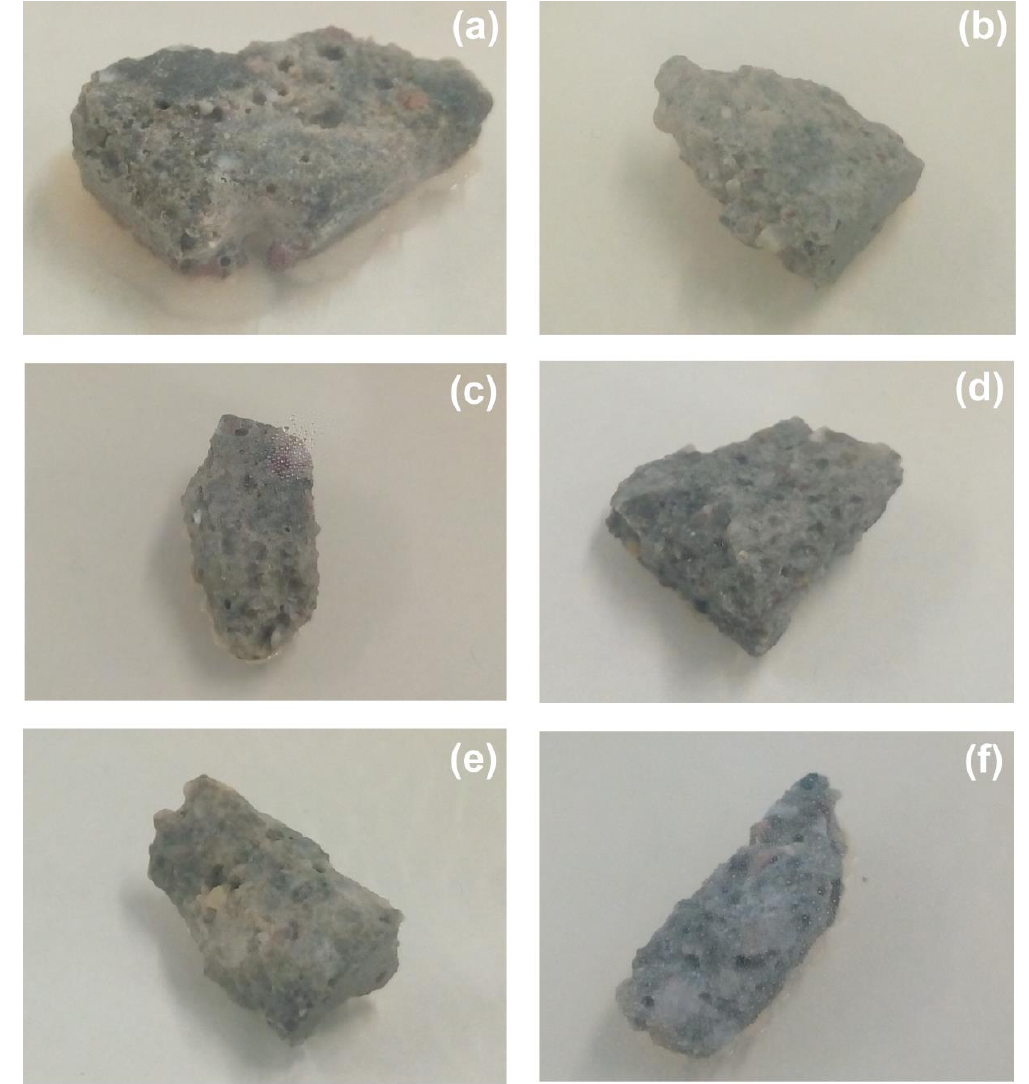
Figure 7. Example images of samples subjected to microbial purity testing: ( a ) clean cement mortar;